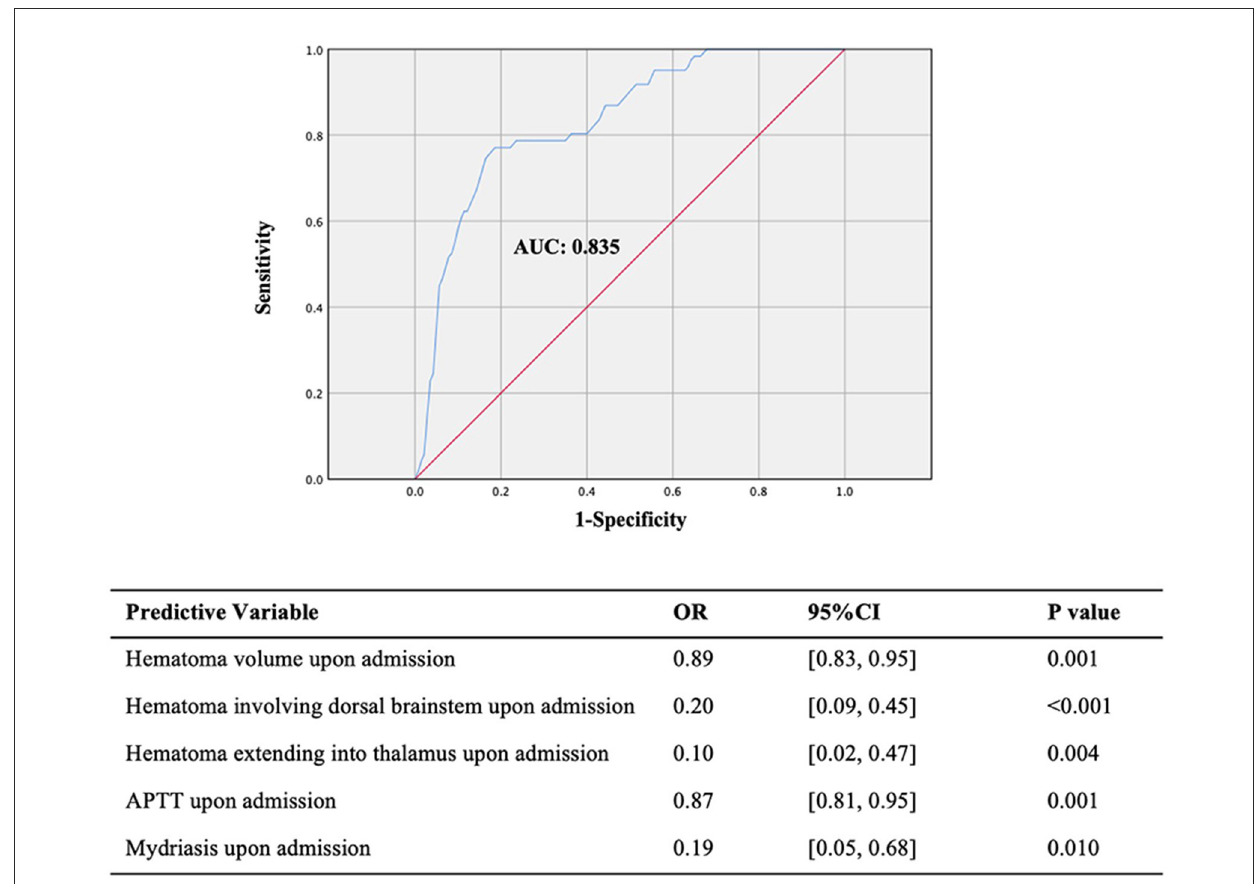
FIGURE4 ROC of the prediction model for the 90-day consciousness